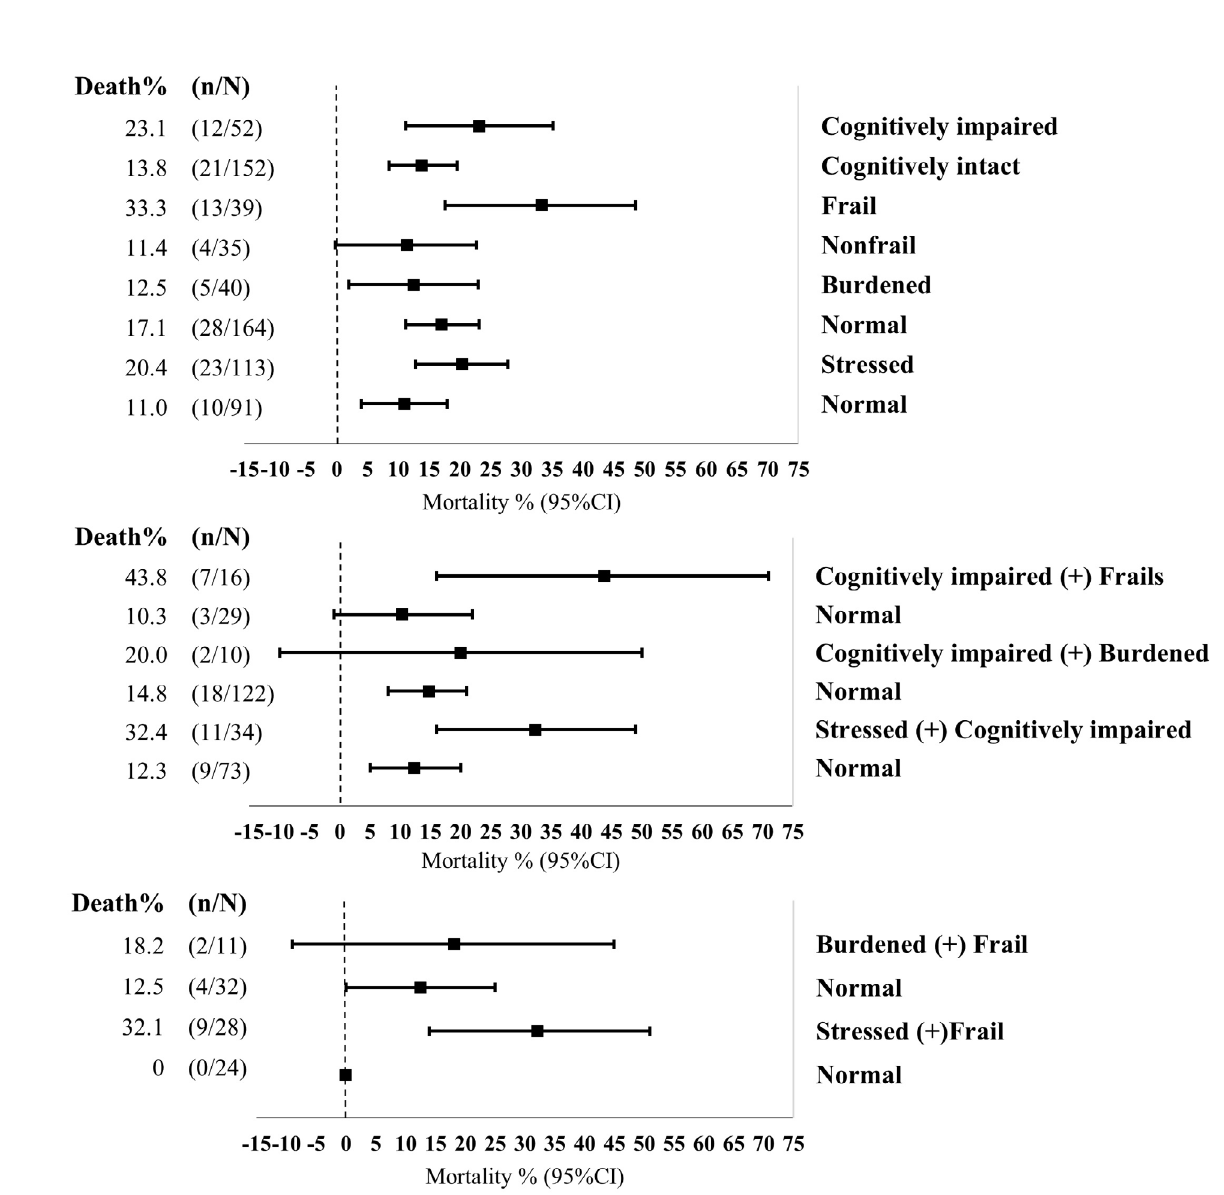
Figure 3. Forest plot of caregiver deaths (%) considering accumulated conditions in older caregivers. X-axis denotes percentages (%) with absolute frequency of caregiver deaths (n) among participants with accumulated conditions; Y-axis denotes plots represent percentages and error bars represent 95% confidence intervals of percentage (%) of cases of caregiver